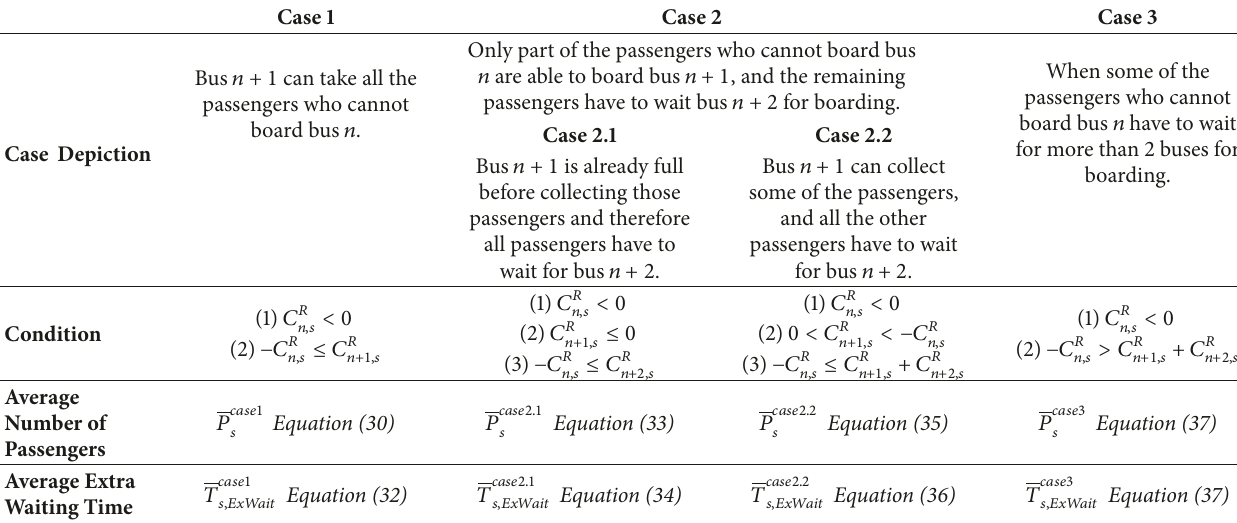
Table 4: All possible cases of